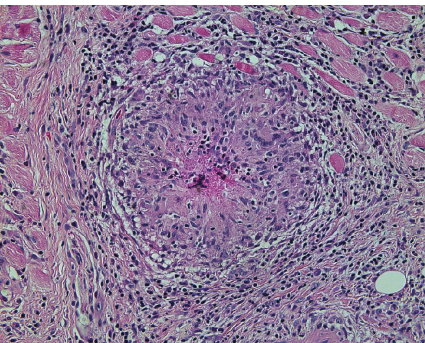
Figure 5: Higher magnification of 20x view showing multinucle- ated giant cells within the muscle and focal endomysial infiltrates of lymphocytes and plasma cells, consistent with a diagnosis of orbital sarcoid , although CT chest and ongoing followup have excluded systemic